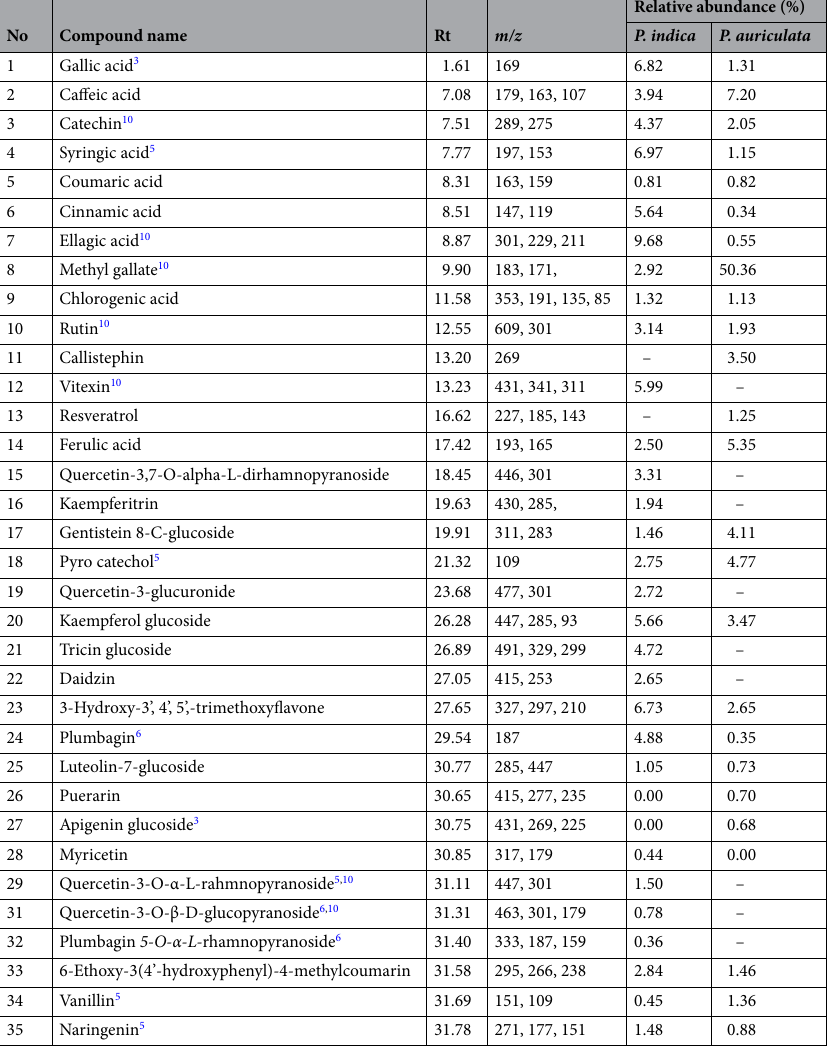
Table 1. Phenolic compounds of the hydroalcoholic extracts of the aerial parts of Plumbago indica and P. auriculata by LC–MS–MS. RT. (min): Retention time per minute. M/Z: mass fragmentation.